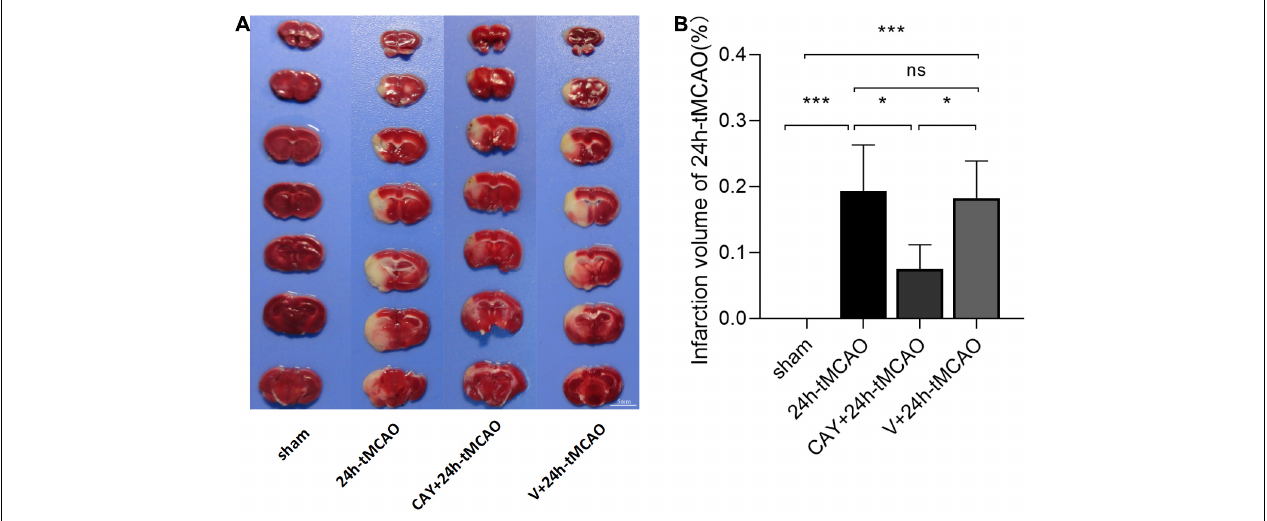
FIGURE 1 | Infarction volume of mice subjected to tMCAO after administration of an S1PR3-specific antagonist. (A,B) Representative images and statistical results of TTC staining of brain tissues in different groups ( n = 4). Scale bar = 5 mm. Data are presented as the mean ± SEM. P -values were determined by ANOVA followed by the Tukey post hoc test, * P < 0.05; *** P < 0.001; and ns, not significant.